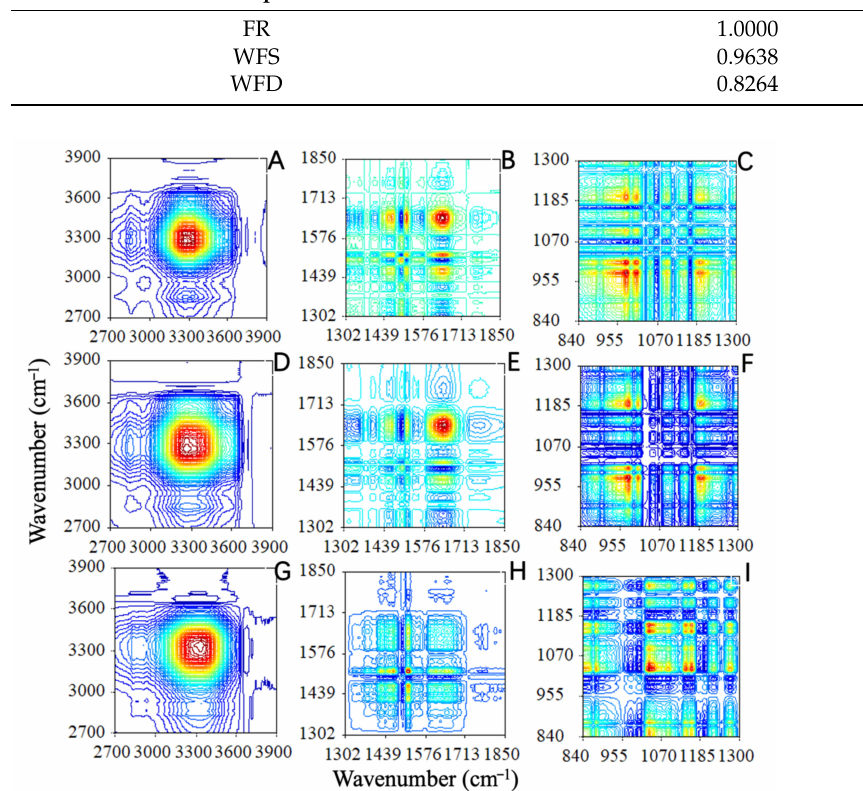
Figure 6. Synchronous 2D COS-IR spectra of FR in the ranges of ( A ) 2700–3900 cm − 1 ,